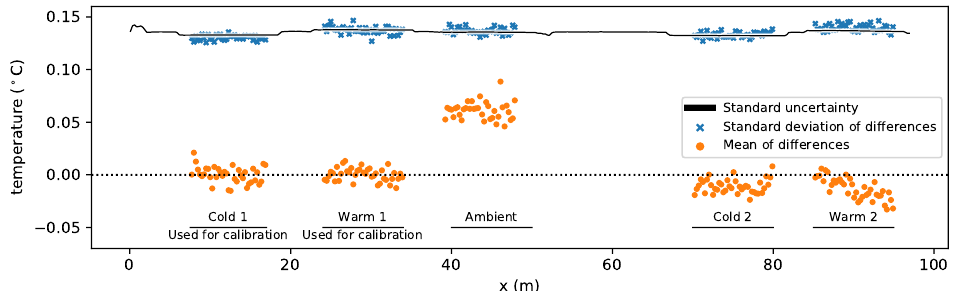
Figure 4. Spatial variation of the standard uncertainty of the estimated temperature, and the mean and standard deviation of the differences between the estimated and reference